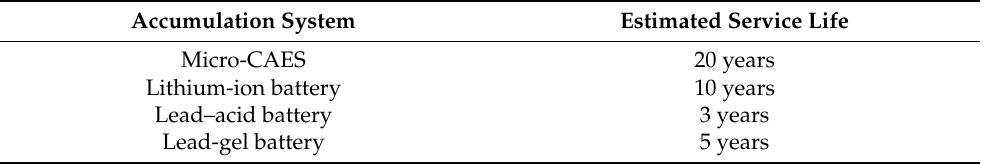
Table 6. Comparison of estimated service life years for different storage